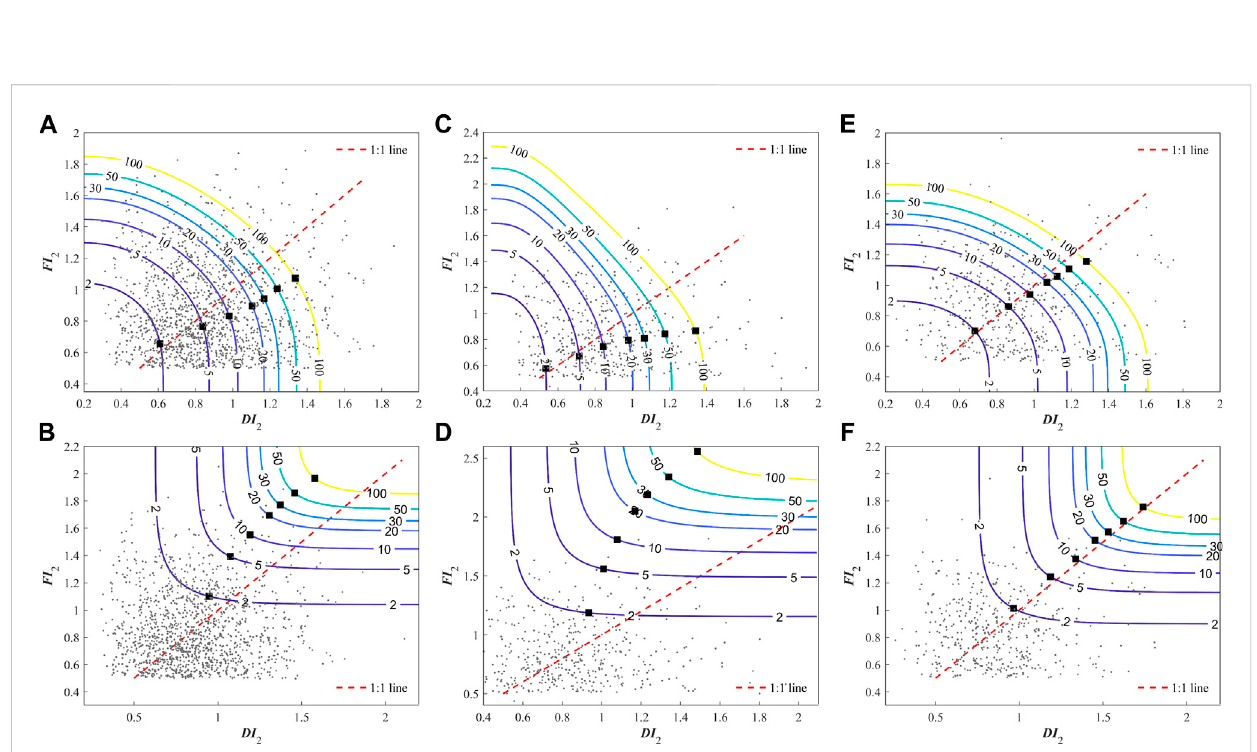
FIGURE 11 Frequency distributions of DI 2 and FI 2 for three sub-basins in the HRB. The various distribution curves are the fi tted frequency distribution. EV is the expectation value of the best- fi tted distribution function: (A) FI2 in UB; (B) DI2 in UB; (C) FI2 in MB; (D) DI2 in MB; (E) FI2 in LB; (F) DI2 in LB.